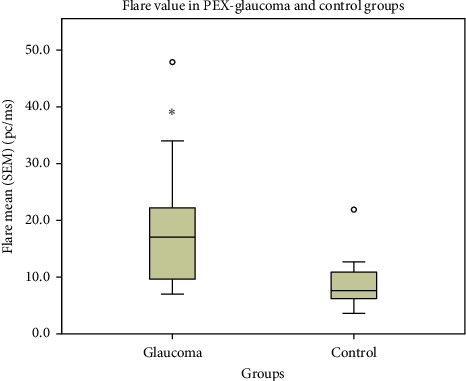
Flare value among PEX-control and glaucoma groups. The glaucoma group showed significantly higher aqueous humour flare mean values than the control group. Ocular surface's subjective and objective evaluation.